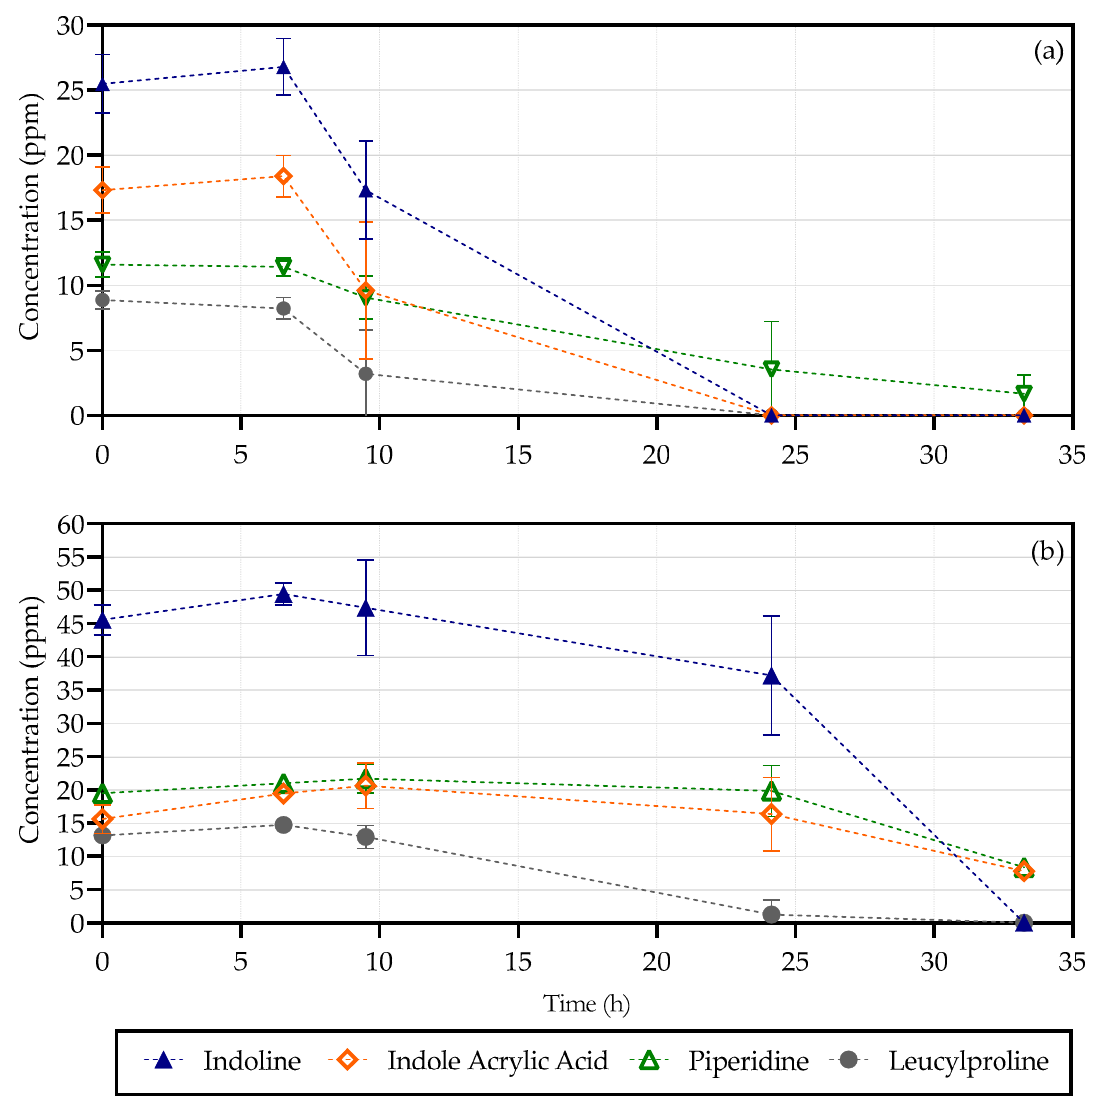
Figure 4. Compounds of interest for the 80 LB ( a ) and 500 Sim ( b ) samples.